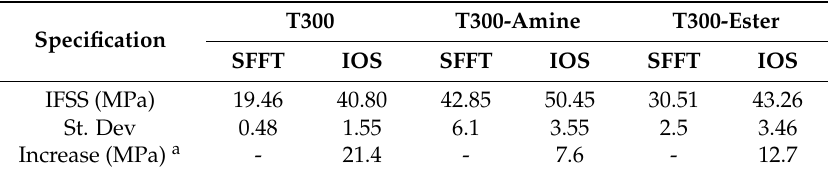
Table 3. Comparison of testing method on fiber